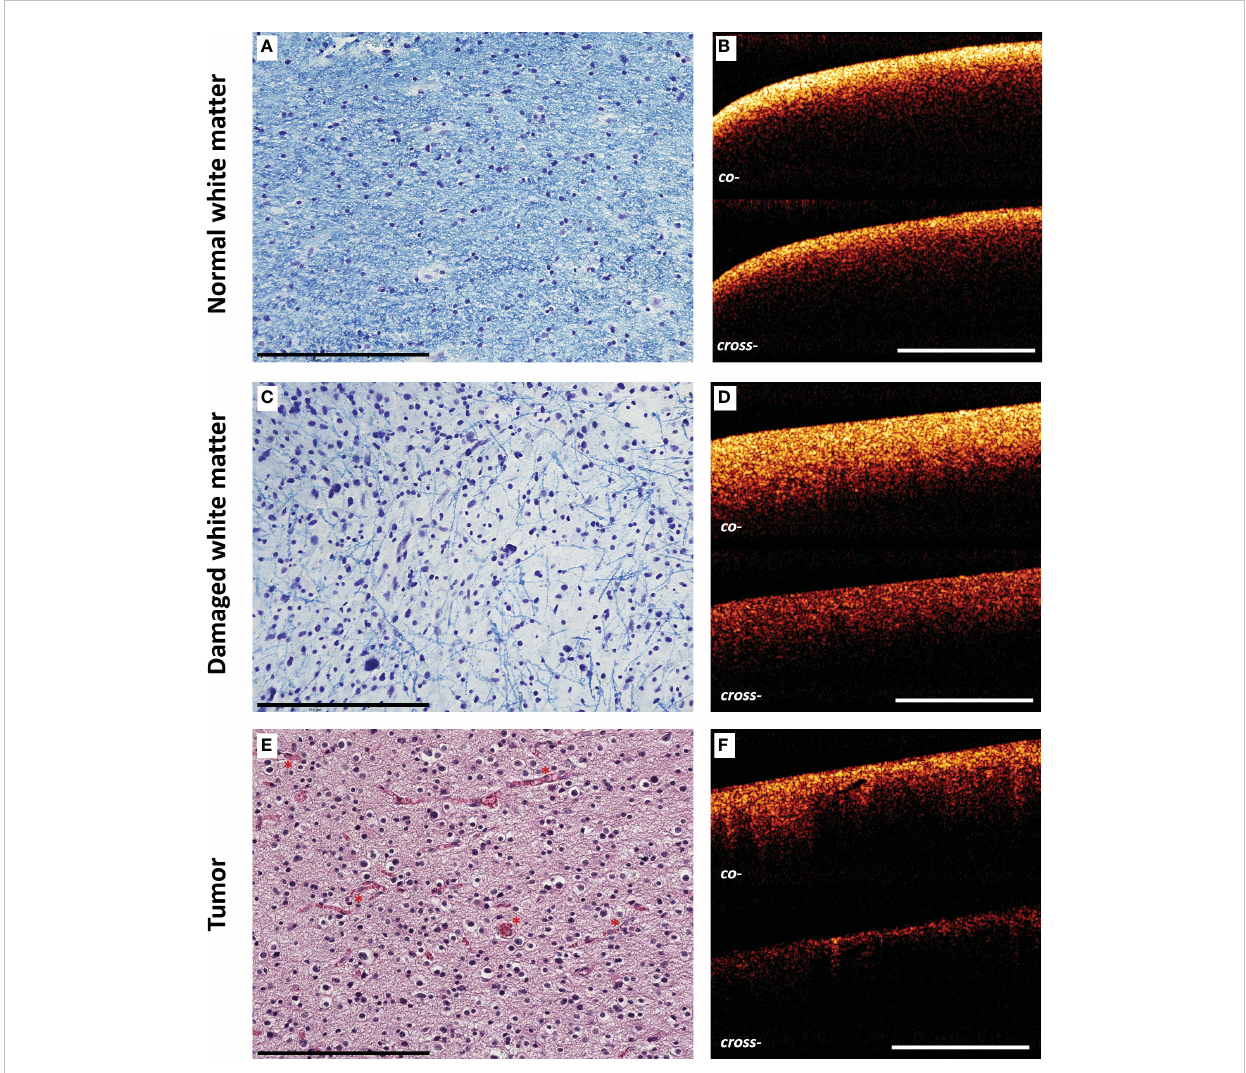
FIGURE 2 Comparison of morphological features of brain tissues and CP OCT signal. Histological images of normal (A) and damaged (B) white matter stained by Luxol fast blue, tumor tissue (C) (astrocytoma Grade III) stained by H&E and corresponding CP OCT images (D – F) , respectively. The destruction of myelinated fi bers in peritumoral area is re fl ected in histological images (only individual preserved fi bers are visualized in comparison with normal white matter) (B) and leads to the changes in CP OCT signal: slight reduction of the signal intensity and decrease in the attenuation rate in both polarizations (E) . Fundamentally different structural characteristics of the tumor, expressed in the predominance of cellular elements, the presence of a large number of blood vessels (marked by red asterisks), are re fl ected in a decrease in the intensity of the OCT signal in both polarizations and its heterogeneity (F) . Scale bar = 200 µm on histological image and 1 mm on OCT image.